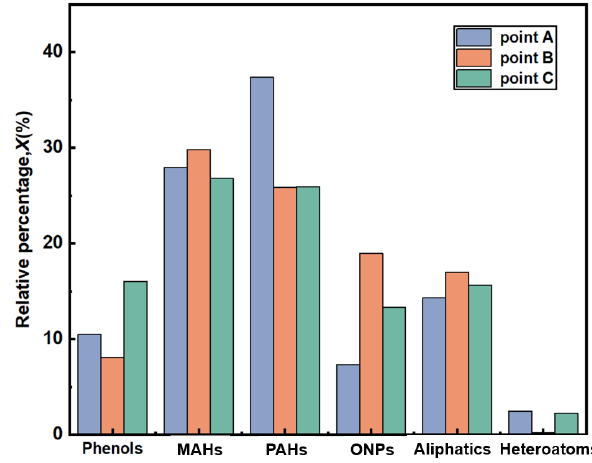
Figure 6. The compound types of different tar samples.